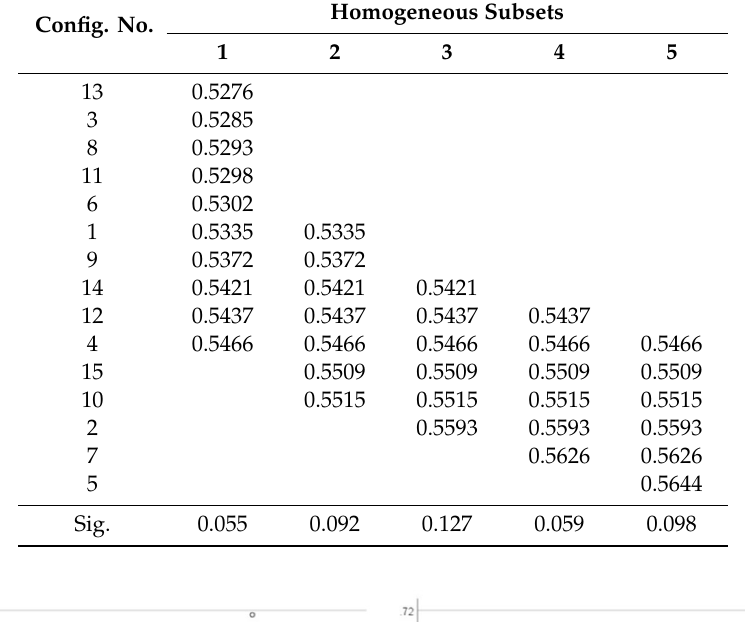
Table 2. Homogeneous subsets of configurations with post-hoc tests for the IoU score. Config. No.